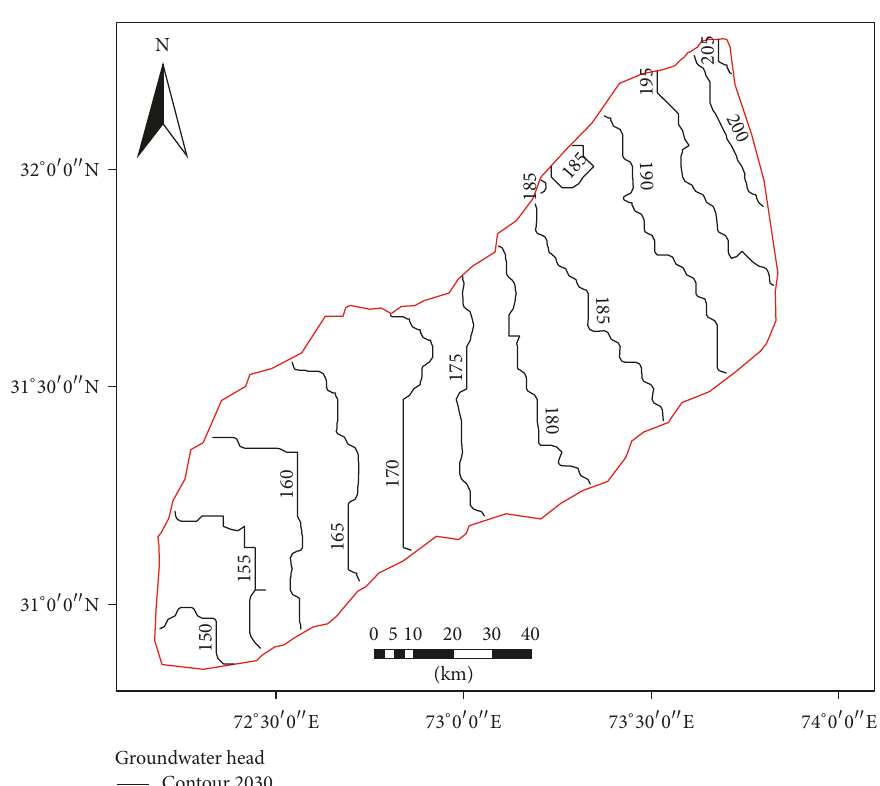
Figure 11: Predicted groundwater level in 2030 (Scenario